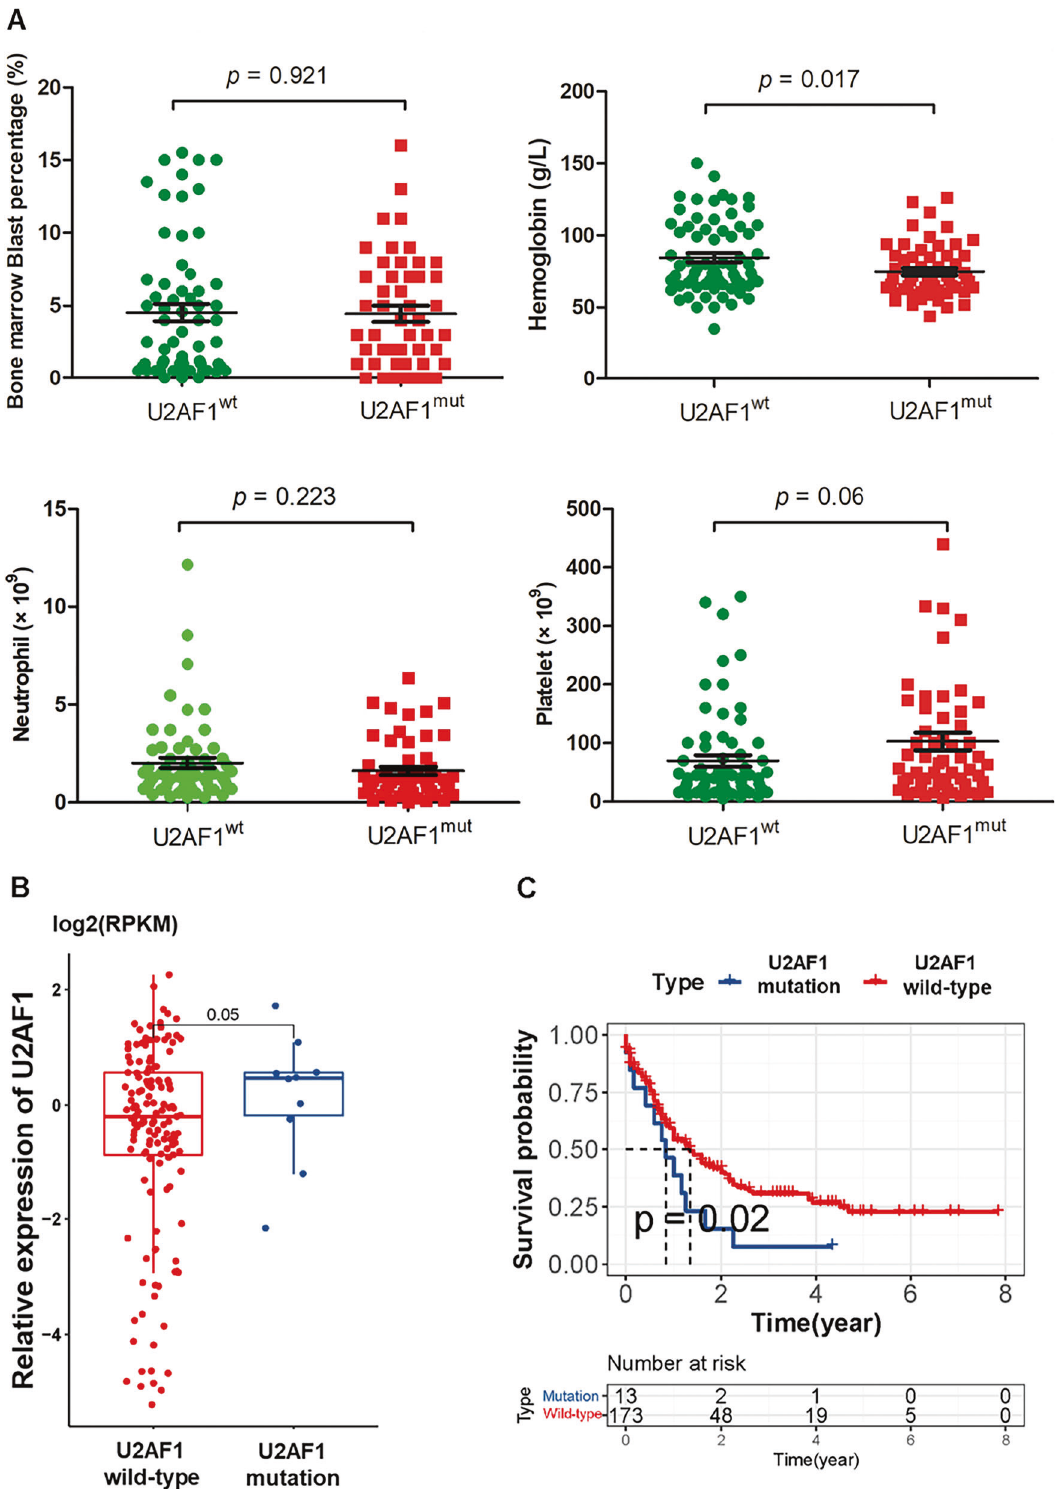
Fig. 1 Mutations of U2AF1 in clinical MDS samples. A The patients carrying the U2AF1 mutations ( n = 58) revealed lower peripheral blood cell counts compared with those without a U2AF1 mutation ( n = 68). B Relative expression of U2AF1 from TCGA-seq dataset. No signi fi cant differences were found for U2AF1 gene expression between mutant and wild-type samples ( p > 0.05). C Kaplan – Meier survival analysis indicated that patients with U2AF1 mutations were signi fi cantly correlated with a shorter overall survival than those without the mutation ( p < 0.05). Statistical signi fi cance in relative expression analysis was determined by log2(RPKM) test.